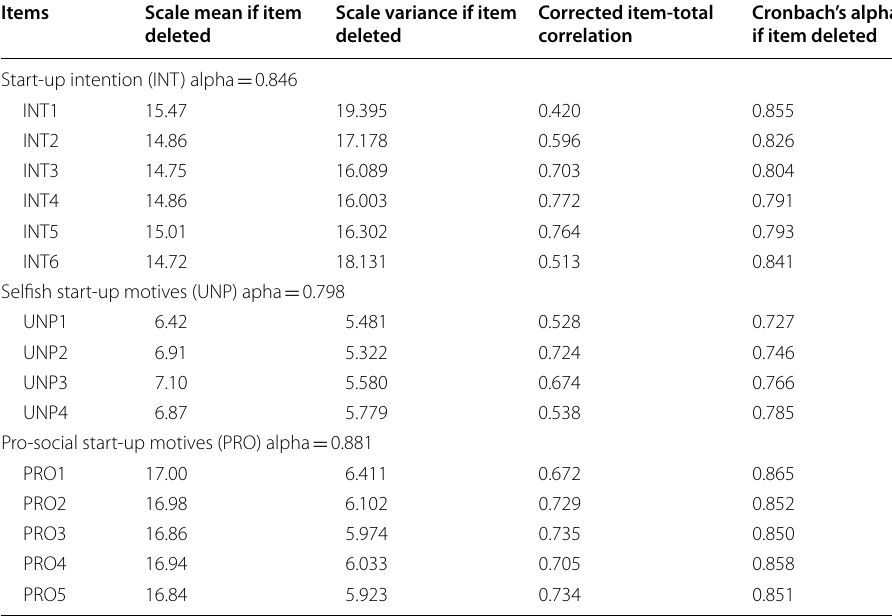
Source: SPSS analysis